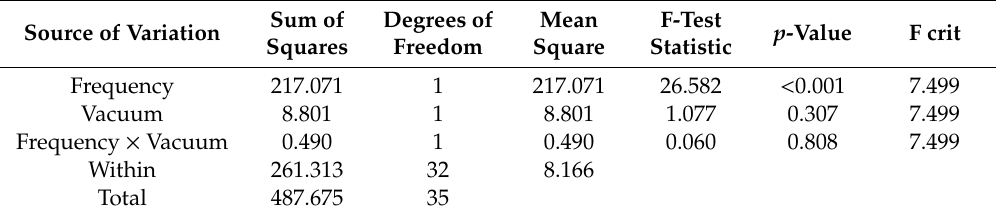
Table 5. Statistical Analysis of Variance results for phase “c”